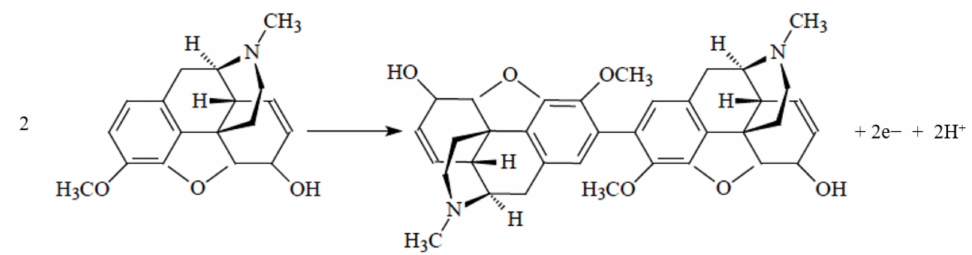
Figure 2. Proposed mechanism for the electro-oxidation of codeine